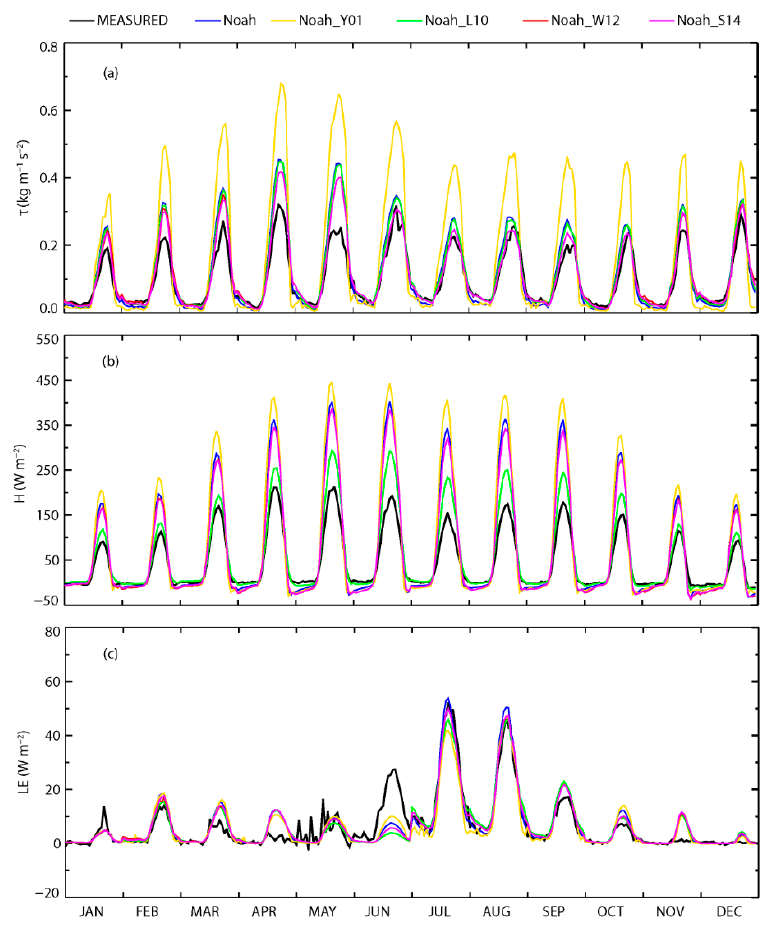
Figure 2. Simulated and observed monthly mean diurnal cycles of (a) momentum flux ( τ ), (b) sensible heat flux (H), and (c) latent heat flux (LE) at Shiquanhe. Table 2. Coefficients of correlation (R), model efficiency index (NSE), mean bias error (MBE), and root mean square error (RMSE) between observation and simulation of momentum flux, sensible heat flux, and latent heat flux.